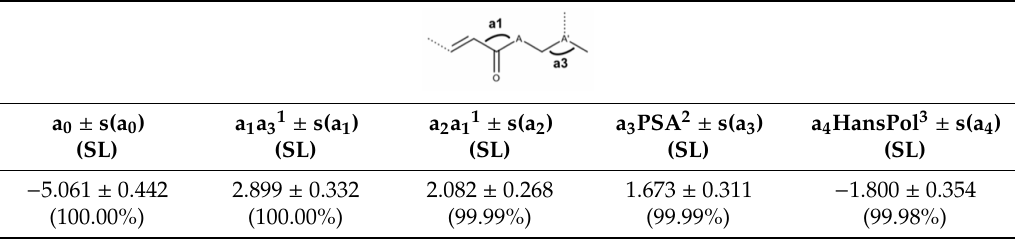
1 a1 and a3 correspond to the angles represented in picture of Table 2. 2 PSA : polar surface area. 3 HansPol : Hansen polarity.